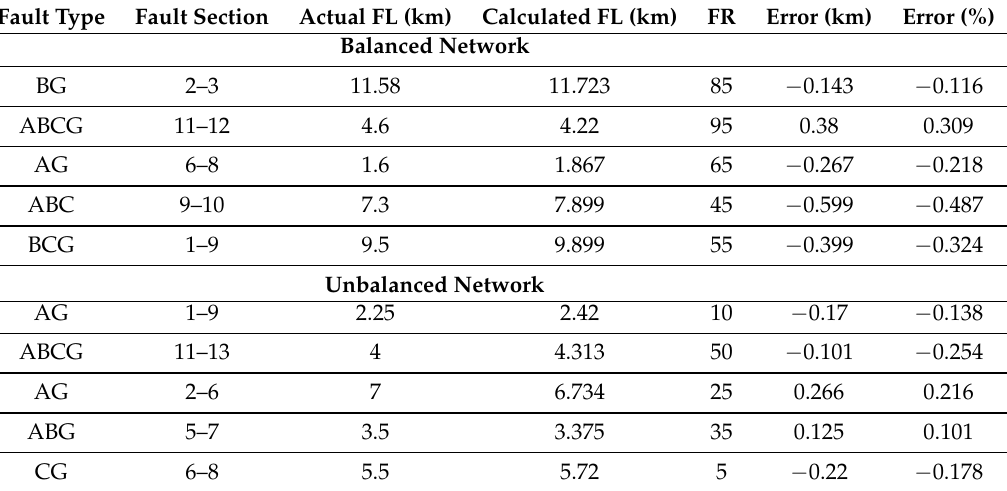
Table 6. Fault location results.